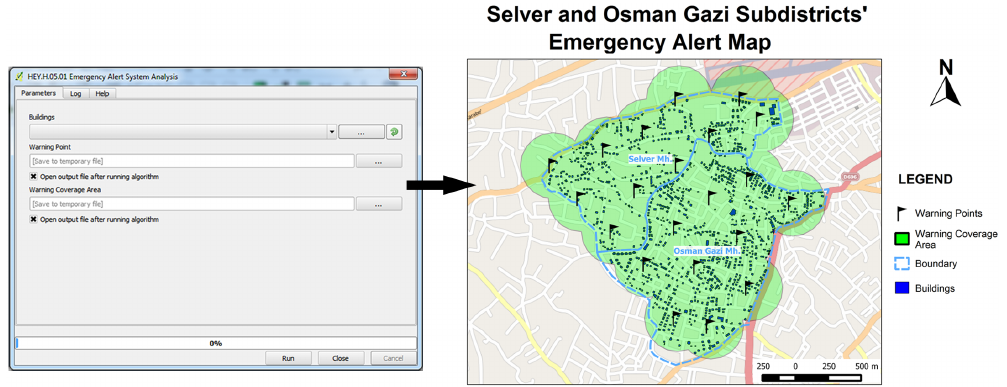
Figure 9. User interface and data sets produced for disaster warning system in Meram, Konya,